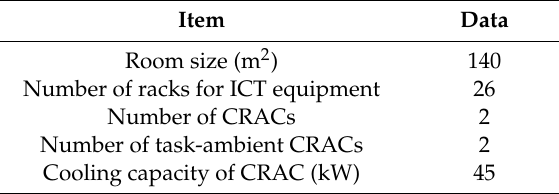
Figure 2. Floor plan of verification room. Table 1. Specifications of verification server room and CRAC.